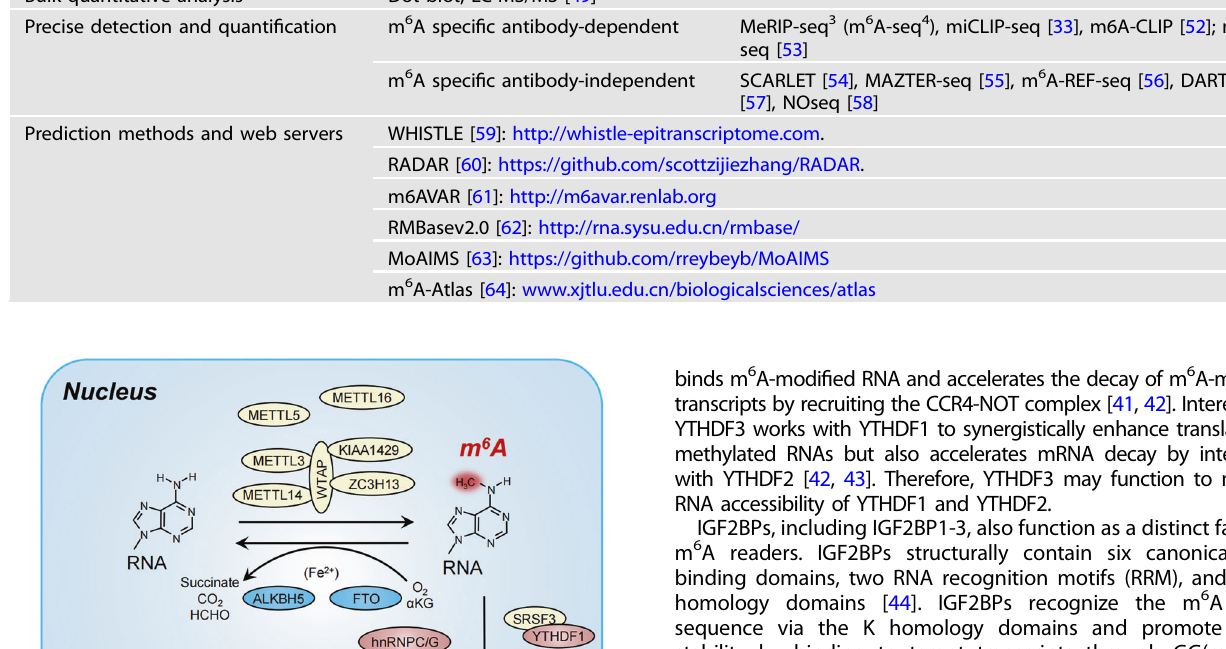
Table 1. Methodologies for m 6 A detection. Bulk quantitative analysis Precise detection and quanti fi cation